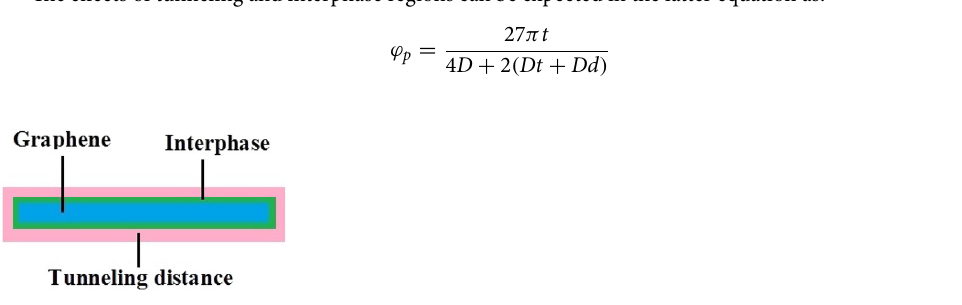
Figure 1. Schematic representation of interphase and tunneling regions in a